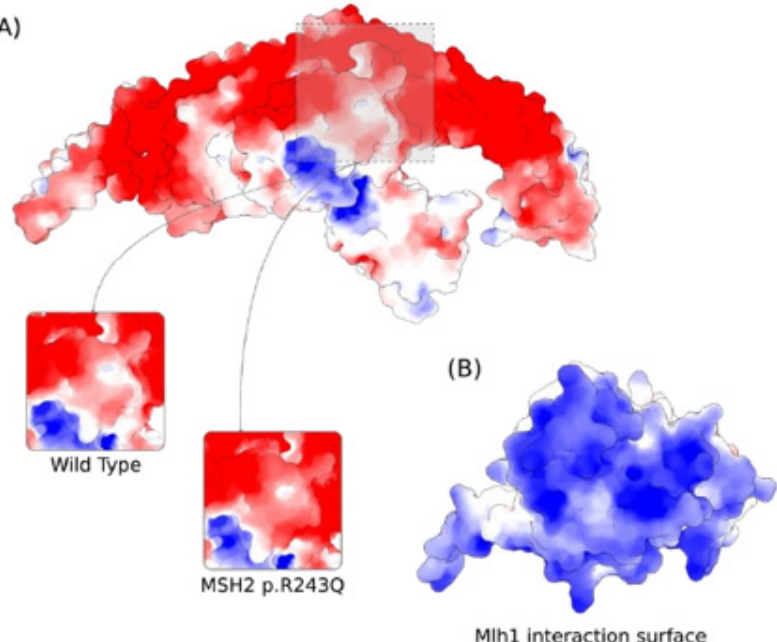
Figure 5. Predicted effect of MSH2 p.R243Q variant on the electrostatic properties of MSH2 calcu- lated by the Adaptive Poisson–Boltzmann Solver. Red and Blue colors correspond to potentials of electronegative and electropositive intensities, respectively. The maximum intensity values are − 5 and +5 kb T e − 1 . ( A ) Electrostatic potential of MSH2 showing the variation at the site of the mutation for the wild type and p.R243Q forms. ( B ) Electrostatic potential of MLH1 at the interaction surface with MSH2.